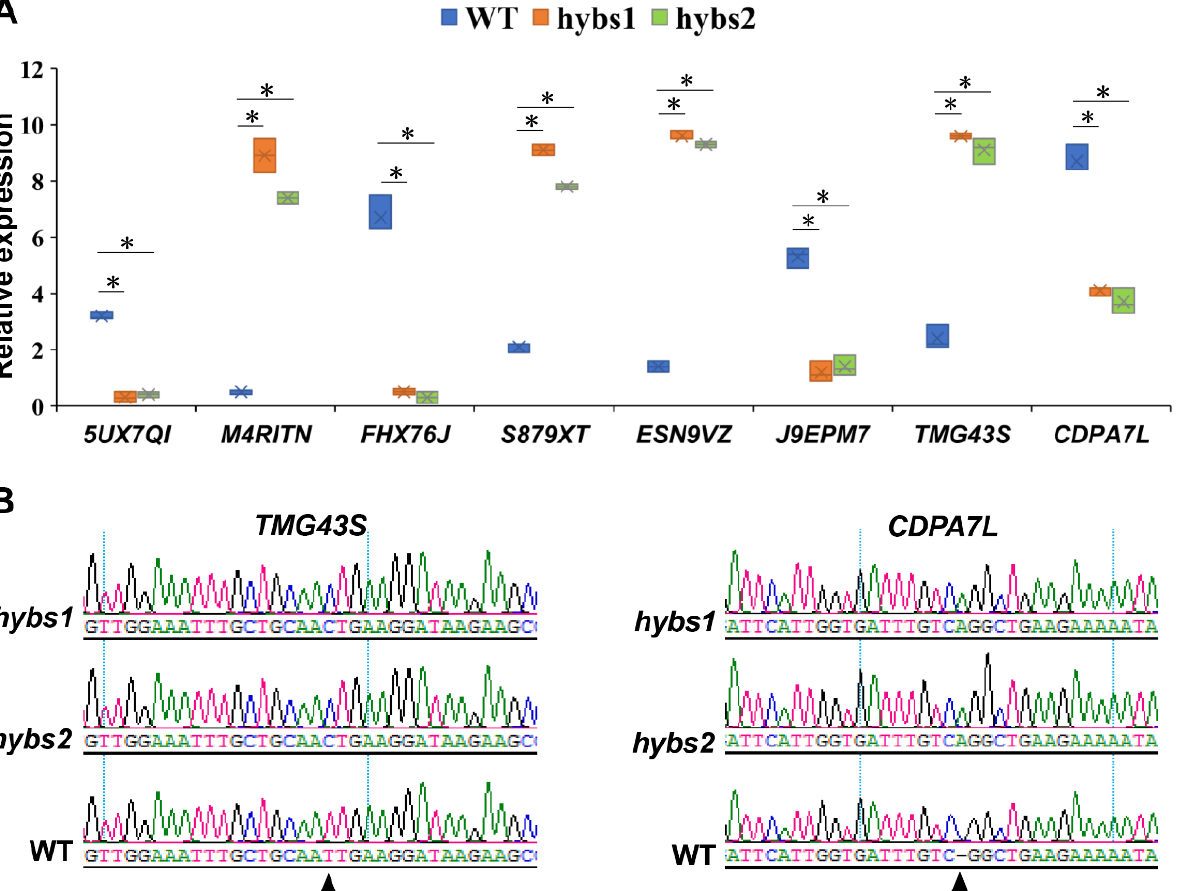
Figure 5. qRT-PCR verification of DEGs between hybs and WT lines. ( A ) qRT-PCR analysis of 8 genes expression in seed samples in WT and hybs plants. (Mann-Whitney U -test; * p < 0.01). ( B ) Results of Sanger sequencing for the hybs mutants and WT. The arrows indicated the mutations.